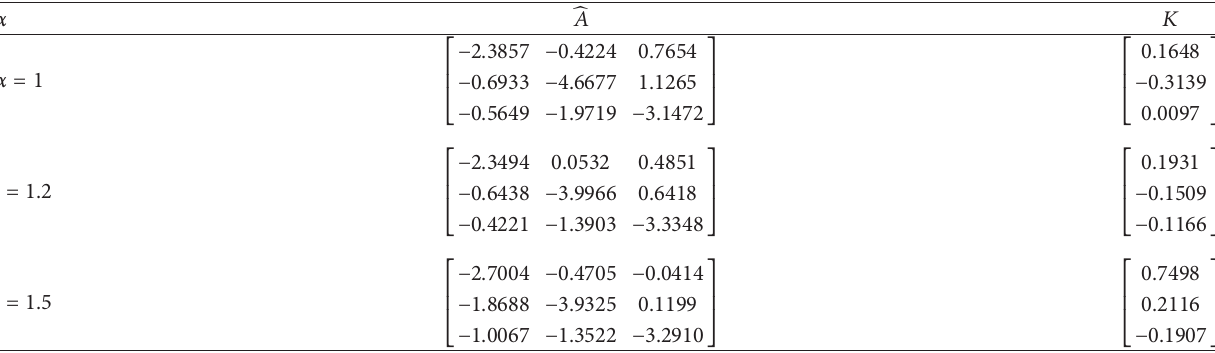
Table 1: Estimator matrices